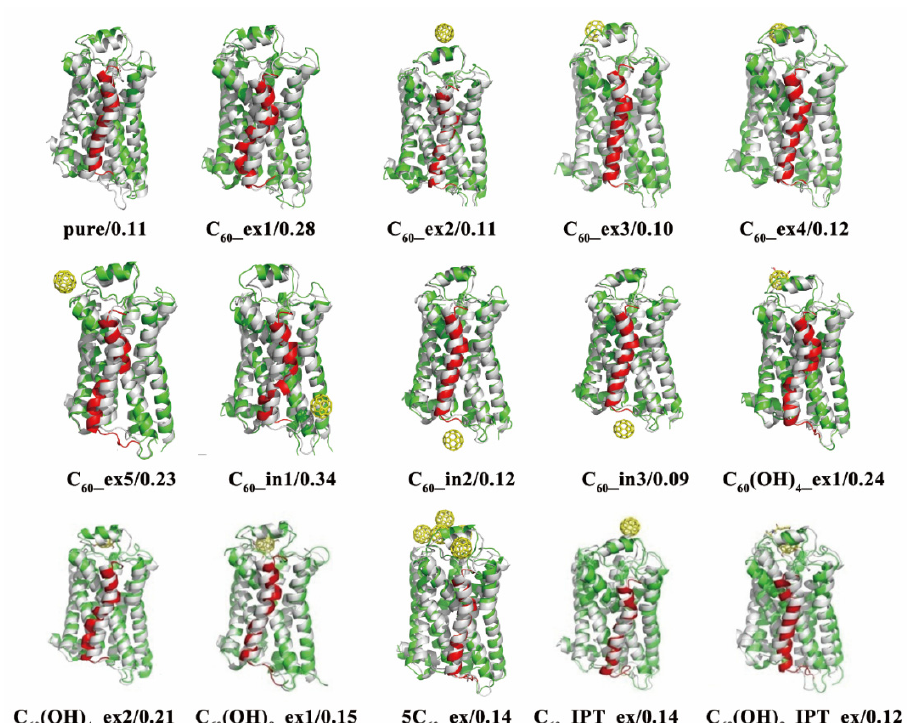
Figure 10. The conformational changes of the simulated systems. The gray parts of the illustrations denote the crystal structures, and the last snapshots in the simulated system trajectories are shown in green, with the helix4 of each highlighted in red. The yellow models represent C 60 and C 60 (OH) X molecules, and the RMSD values of helix4 with respect to the crystal structure are listed below the structures.